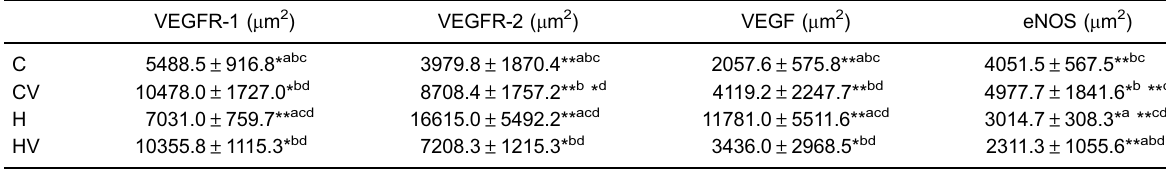
Table 3. Vascular endothelial growth factors (VEGF)R-1, VEGFR-2, VEGF, and endothelial NO synthase (eNOS) score by immuno- histochemistry analysis.